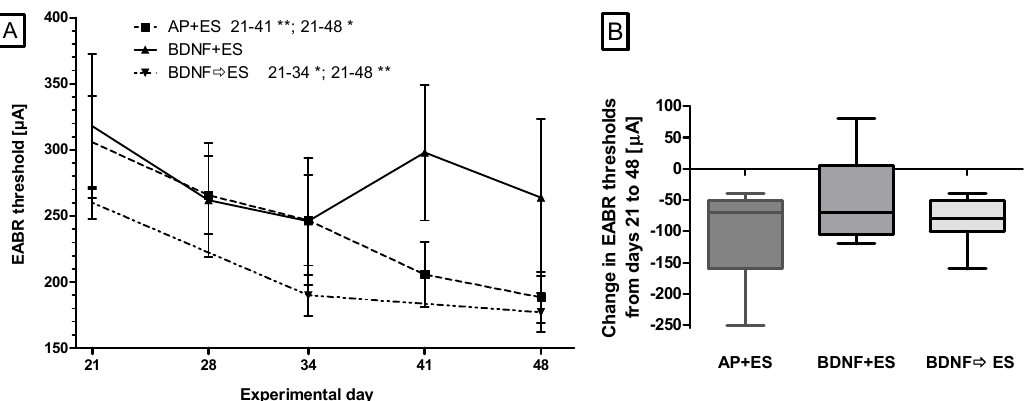
Figure 3. Electrically evoked auditory brainstem responses (EABR) were recorded weekly in all experimental groups except the AP group after electrode implantation from days 21 to 48 (exception: group BDNF ⇨ ES: no measurement on day 28). ( A ) depicts the mean ± SD EABR hearing thresholds over time for each electrically stimulated group. A reduction in threshold was detected only in groups AP + ES and BDNF ⇨ ES. ( B ): No differences between groups were found when comparing the mean threshold shifts between days 21 and 48. * p < 0.05; ** p < 0.01.